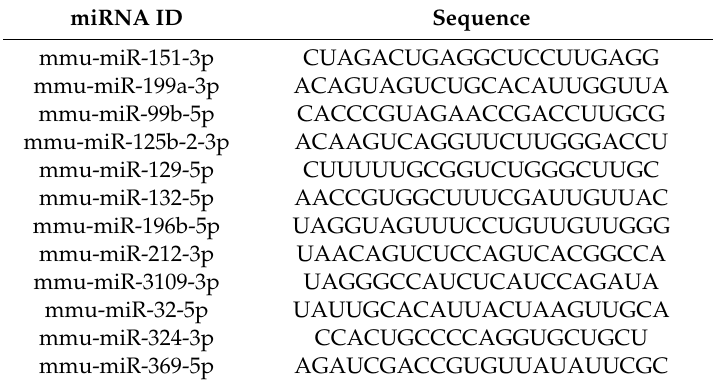
Table 1. Information of the stably enriched di ff erential exosomal